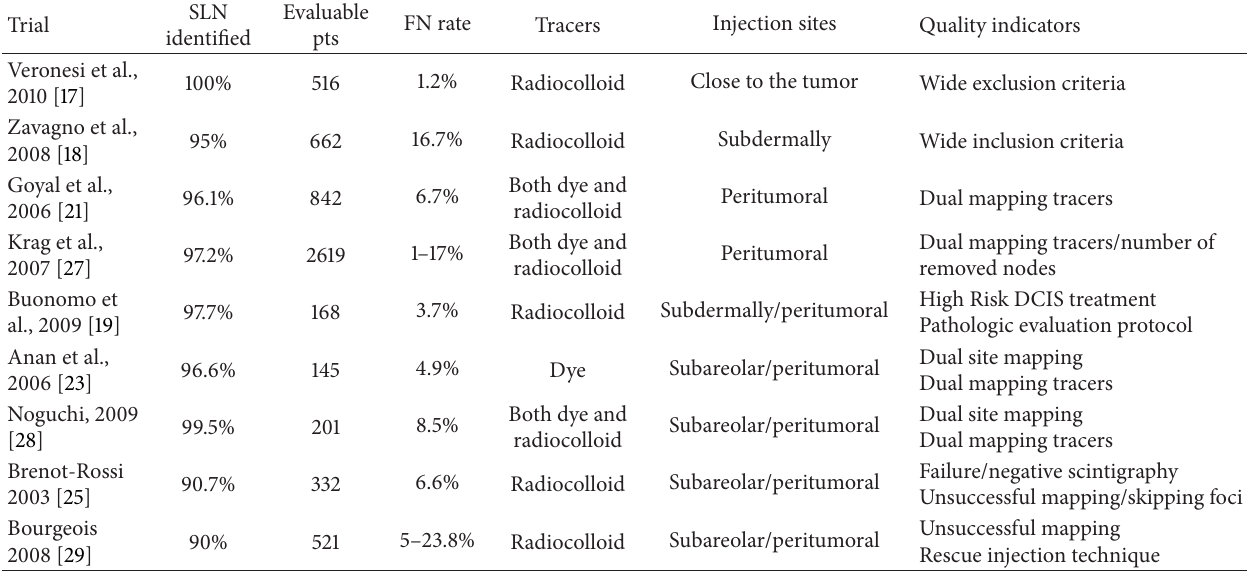
Table 2: Characteristics of studies including systematic review and suggested issues (QIs) for improvement in sentinel node procedures. SLN Evaluable FN rate Tracers Injection sites Quality indicators Trial identified pts 1.2% Radiocolloid Close to the tumor Wide exclusion criteria Subdermally Wide inclusion